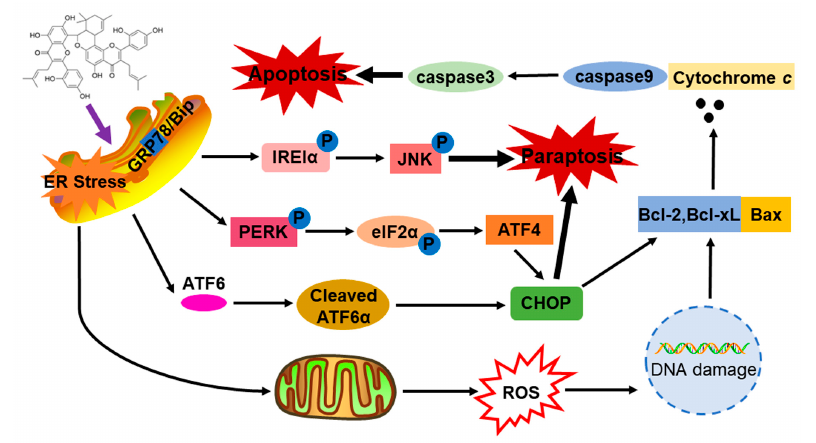
Figure 8. The working model of KWM.